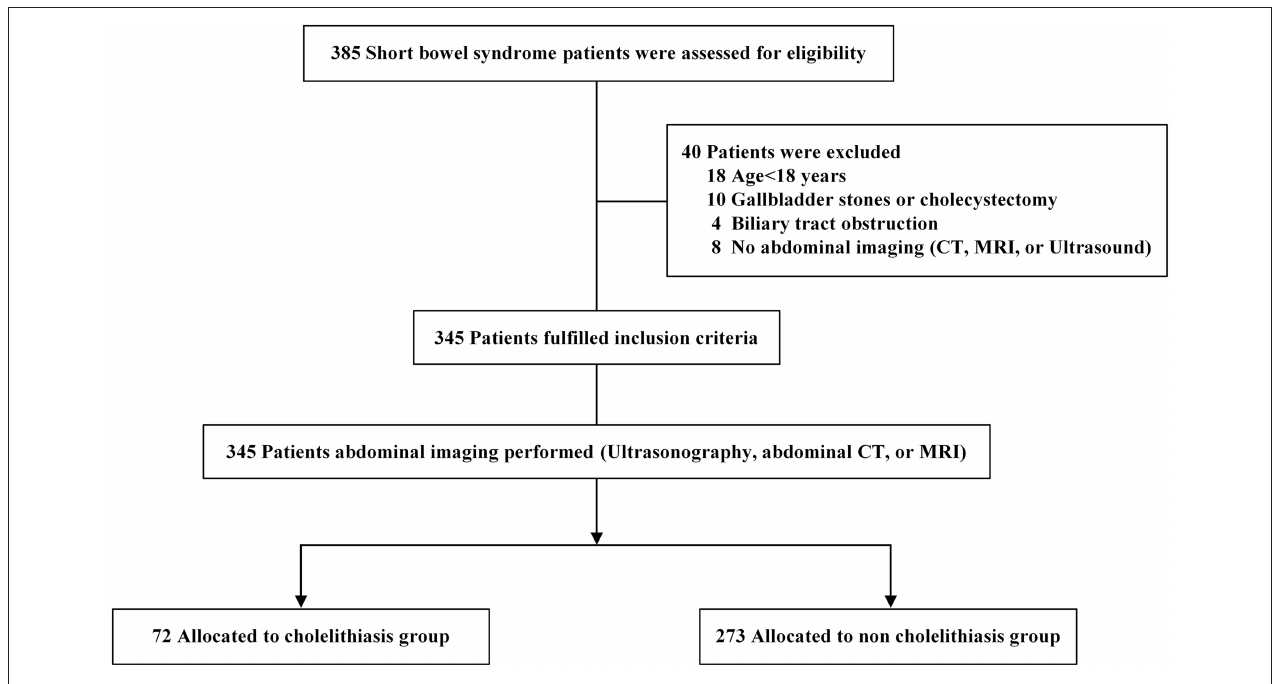
FIGURE 1 | Flow diagram of patients with short bowel syndrome included in the